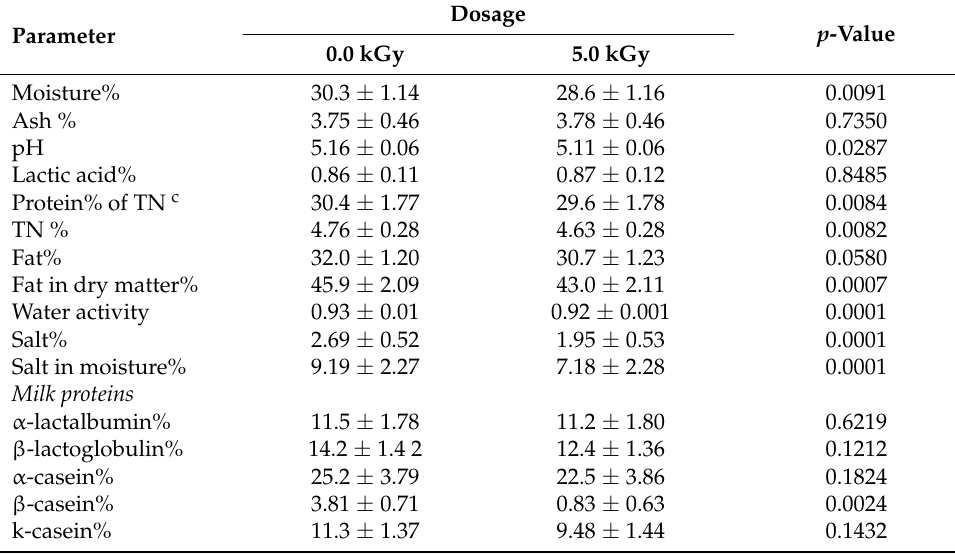
Table 1. Composition (LSM a ± SEM b ) of artisanal pecorino-style hard cheese ( n = 24) at 0.0-kGy and 5.0-kGy dosages of the irradiation